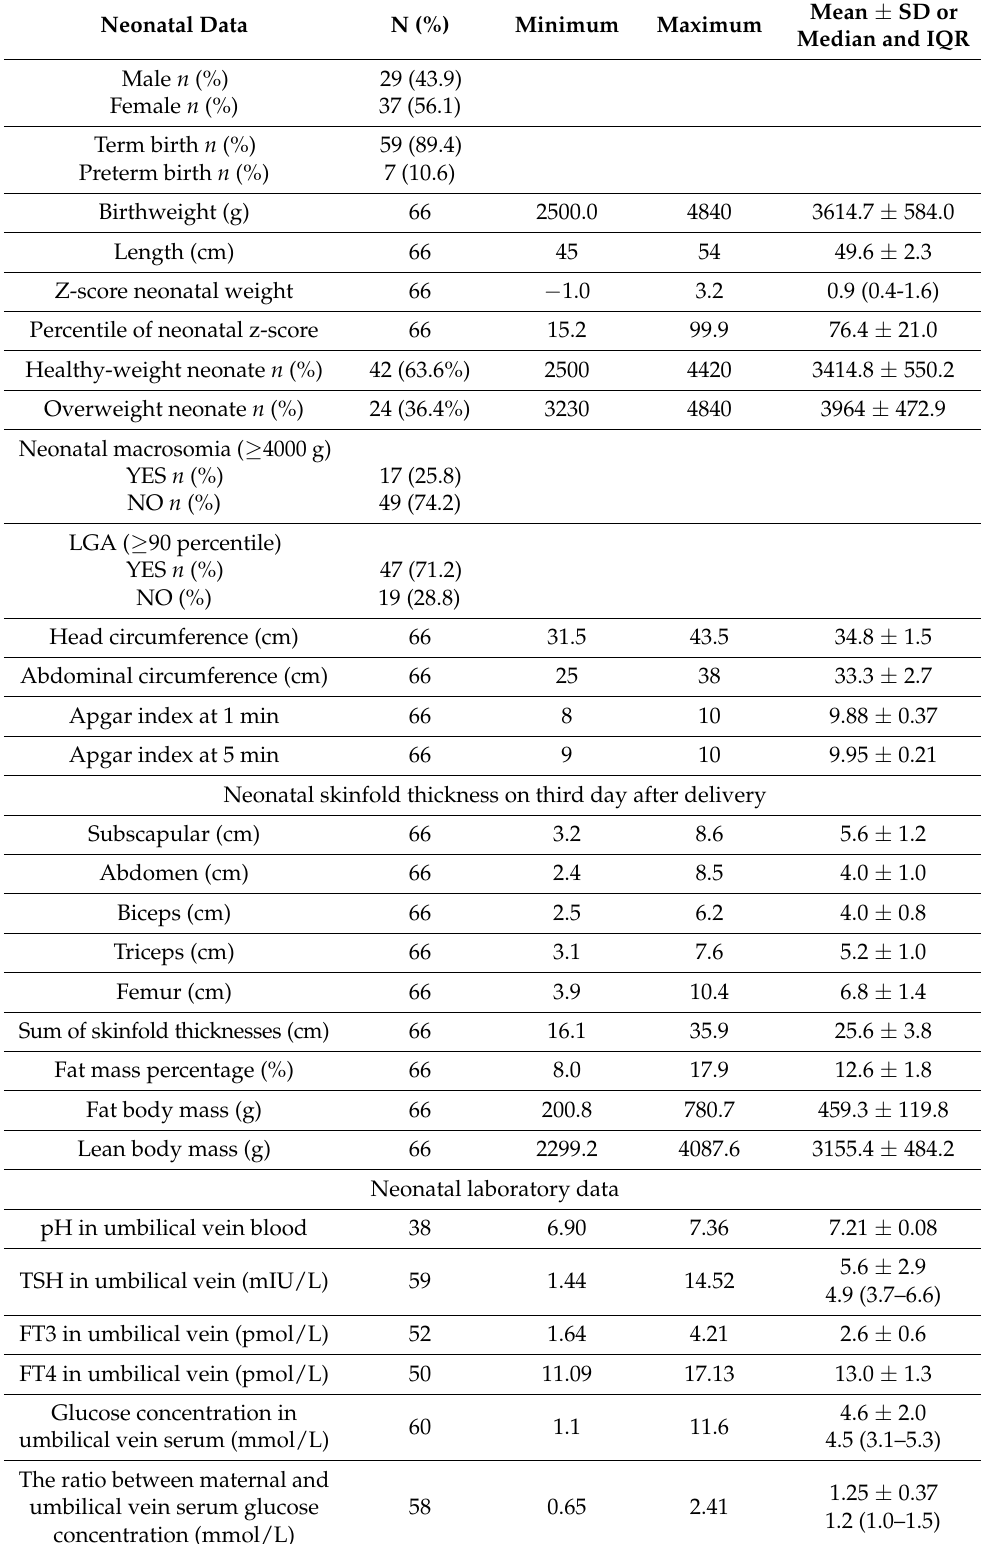
Table 2. Neonatal clinical characteristics and laboratory